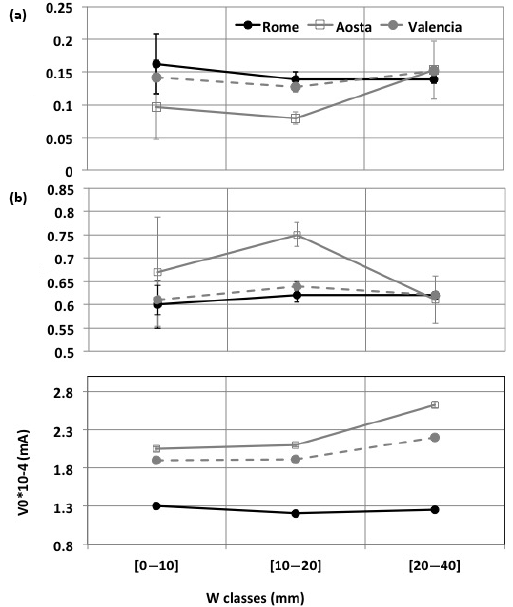
Figure 2. Behaviour of the estimated calibration parameters vs. W classes. The errors bars are the errors affecting the param- eters as evaluated using a Monte Carlo